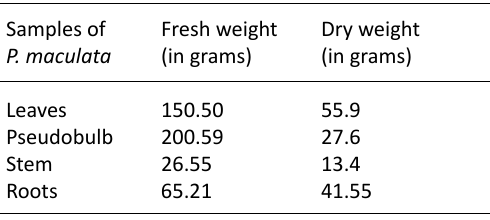
table 2. Fresh and dry weight of different parts of